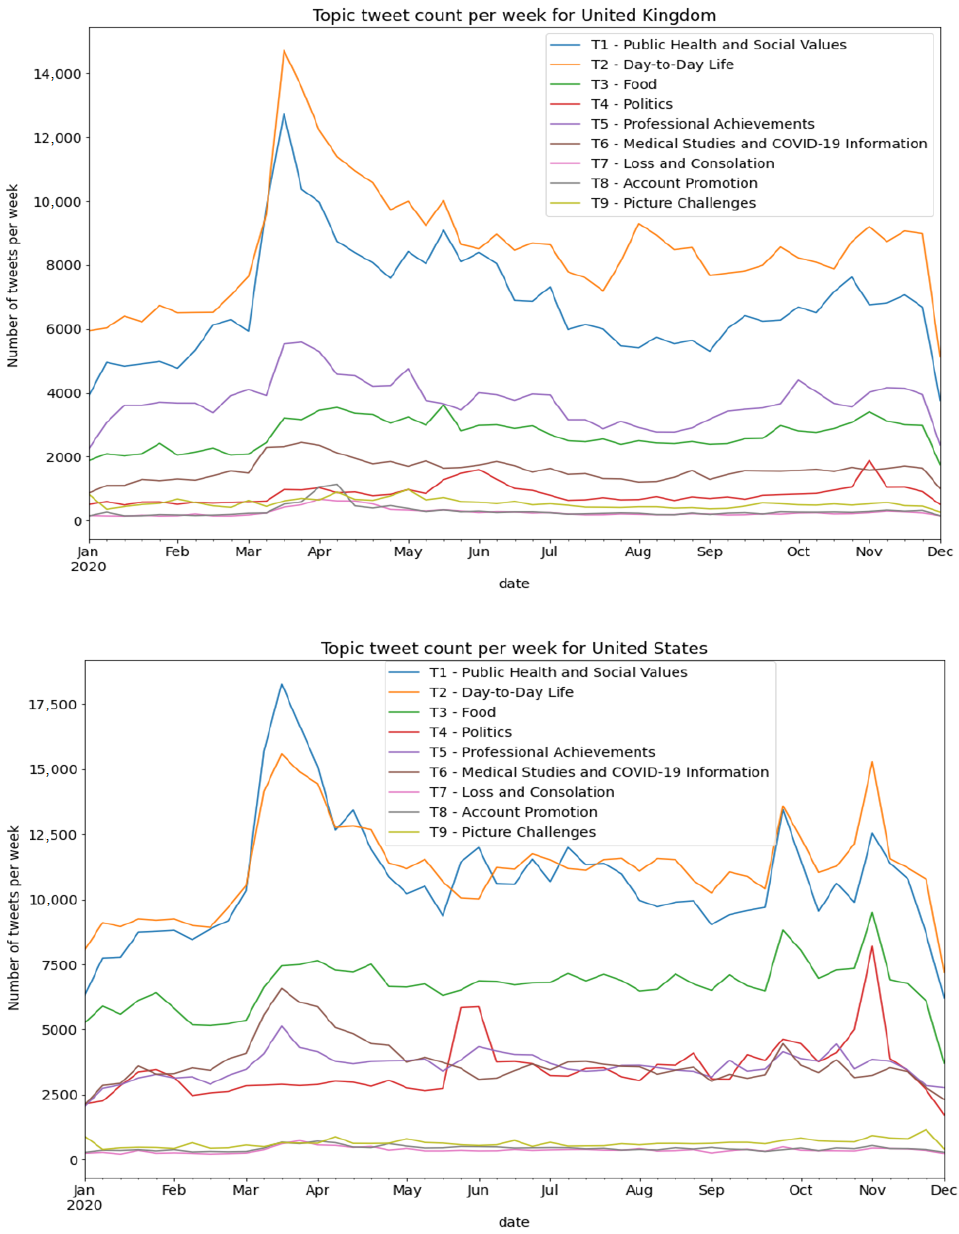
Figure 3. Discourse trends over time—number of tweets per week by US and UK HCPs in 2020.